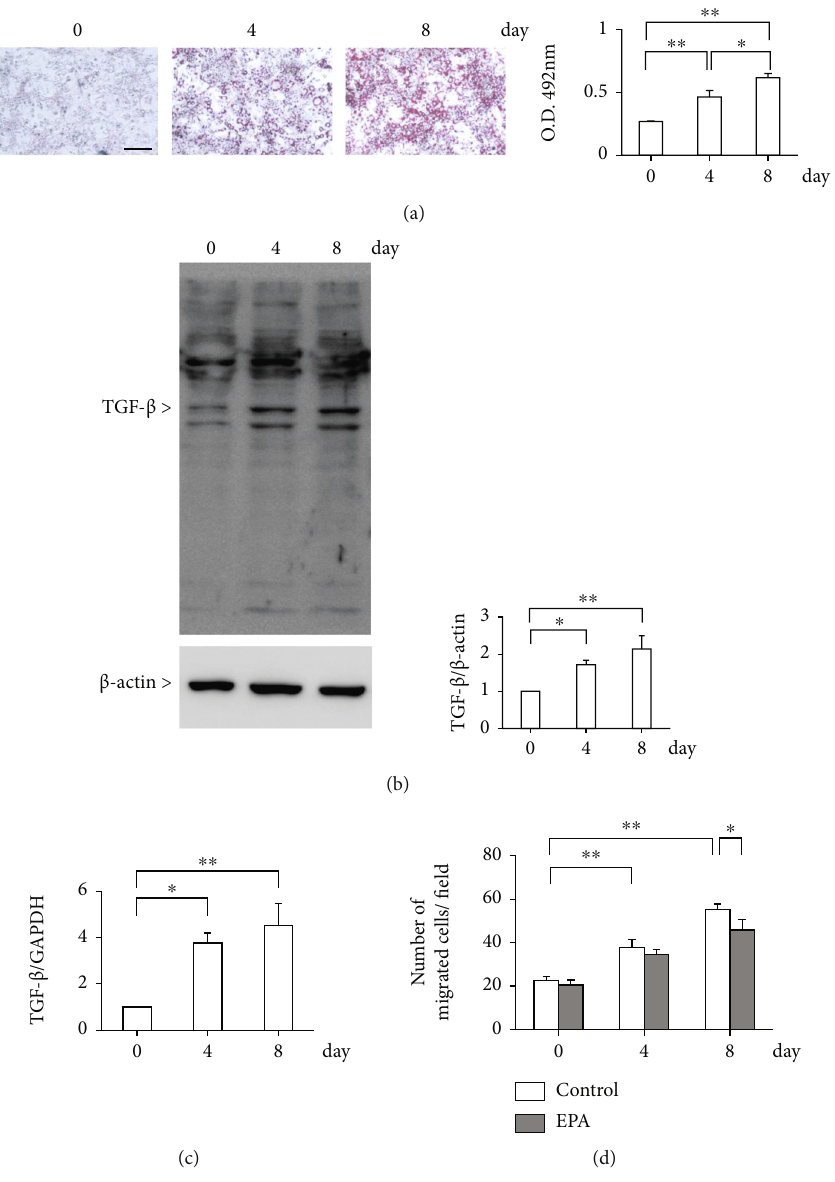
Figure 3: Adipocyte di ff erentiation promotes End-MT and EPA-E inhibits its e ff ect. (a) The 3T3-L1 cells were cultured in di ff erentiation medium for 8 days. Cells that were di ff erentiated into adipocytes were stained with Oil red O staining. Oil red O staining was evaluated by measuring the absorbance of the eluate. Bar = 100 μ m . (b) and (c) Protein expression (b) and mRNA expression (c) of TGF- β in the 3T3L1 preadipocyte cells. (d) End-MT was evaluated using the Boyden chamber assay. ∗ P < 0 : 05 . ∗∗ P < 0 : 01 . These data are expressed as means ± SD